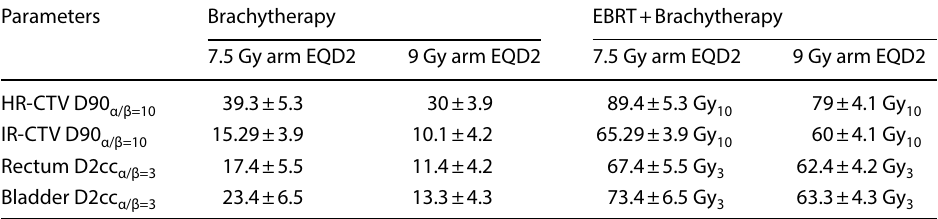
Table 2 Dosimetric parameters of Tumour Volume and Organs at